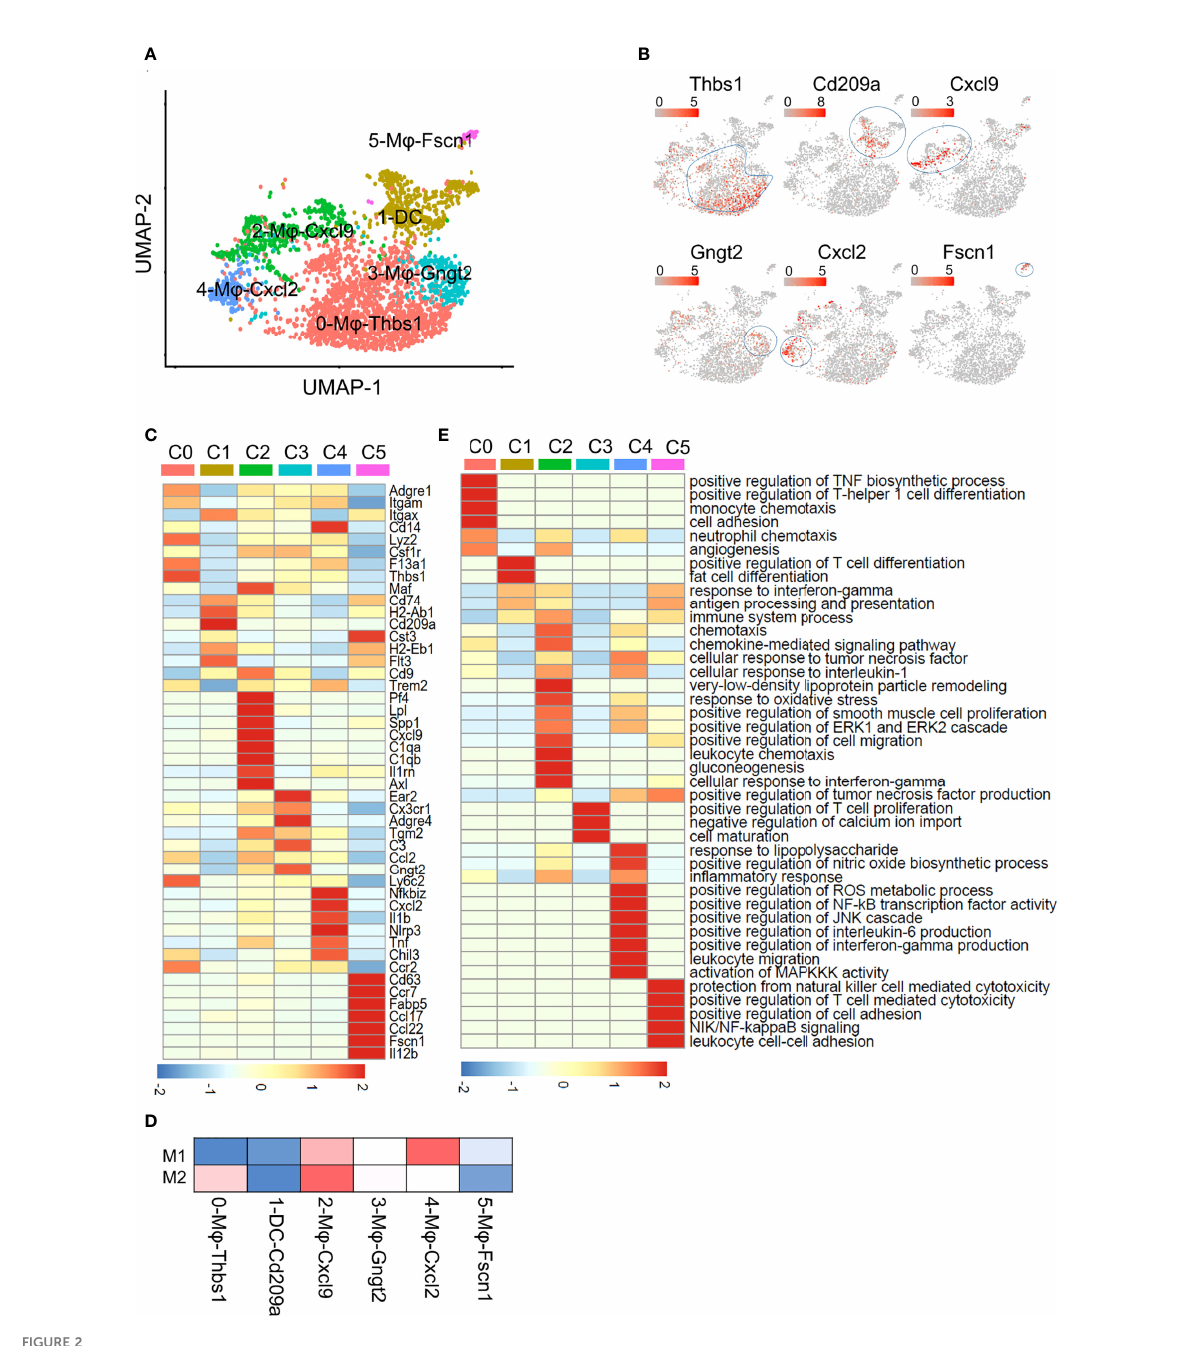
FIGURE 2 Subclustering of macrophages and DCs. (A) UMAP plot of liver macrophages and DCs showing a six-cluster distribution. (B) Feature plots of marker gene expression in six clusters. (C) Heatmap showing the marker genes of each cluster mentioned in (A) . (D) Gene enrichment for classical cell type M1 and M2 in comparisons with the macrophage and DCs subsets in NAFL. (E) GO BP terms enriched in the indicated subset. The gene list is the marker genes of each cluster, colored by -log 10 ( P value ), scaled by